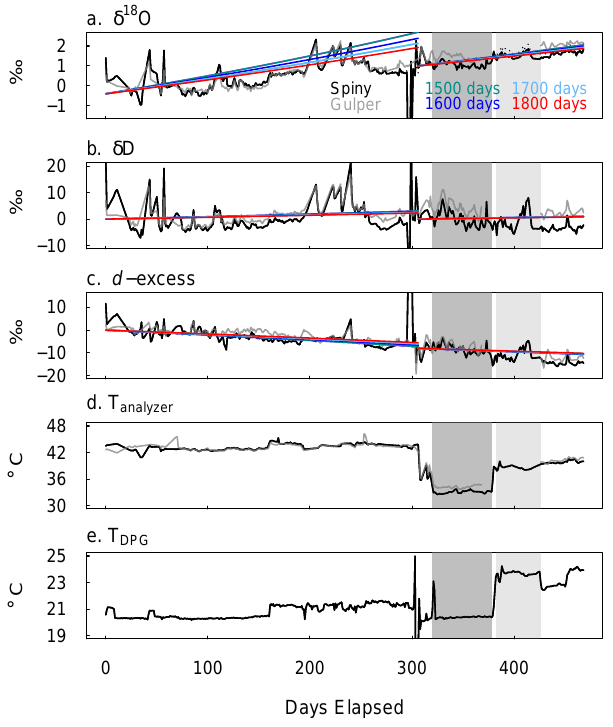
Figure 7. The (a) δ 18 O, (b) δ D, and (c) deuterium excess of the Summit (Spiny in black, Gulper in gray) concentration–corrected calibration points, normalized to the July 2013 mean and plotted as a function of time. In panel (a) Spiny values are shown corrected (solid) and uncorrected (dotted) for DPG temperature fluctuations. Colored lines represent distillation models where τ , the total time required to remove all liquid from the DPG bottle, equals 1500 (green), 1600 (blue), 1700 (light blue), or 1800 (red) days. Varia- tions in the temperatures of the (d) Summit analyzers and (e) DPG bottle are also shown as a function of time. The dark (light) gray shaded regions indicate periods in which the analyzer (DPG) tem- perature changed